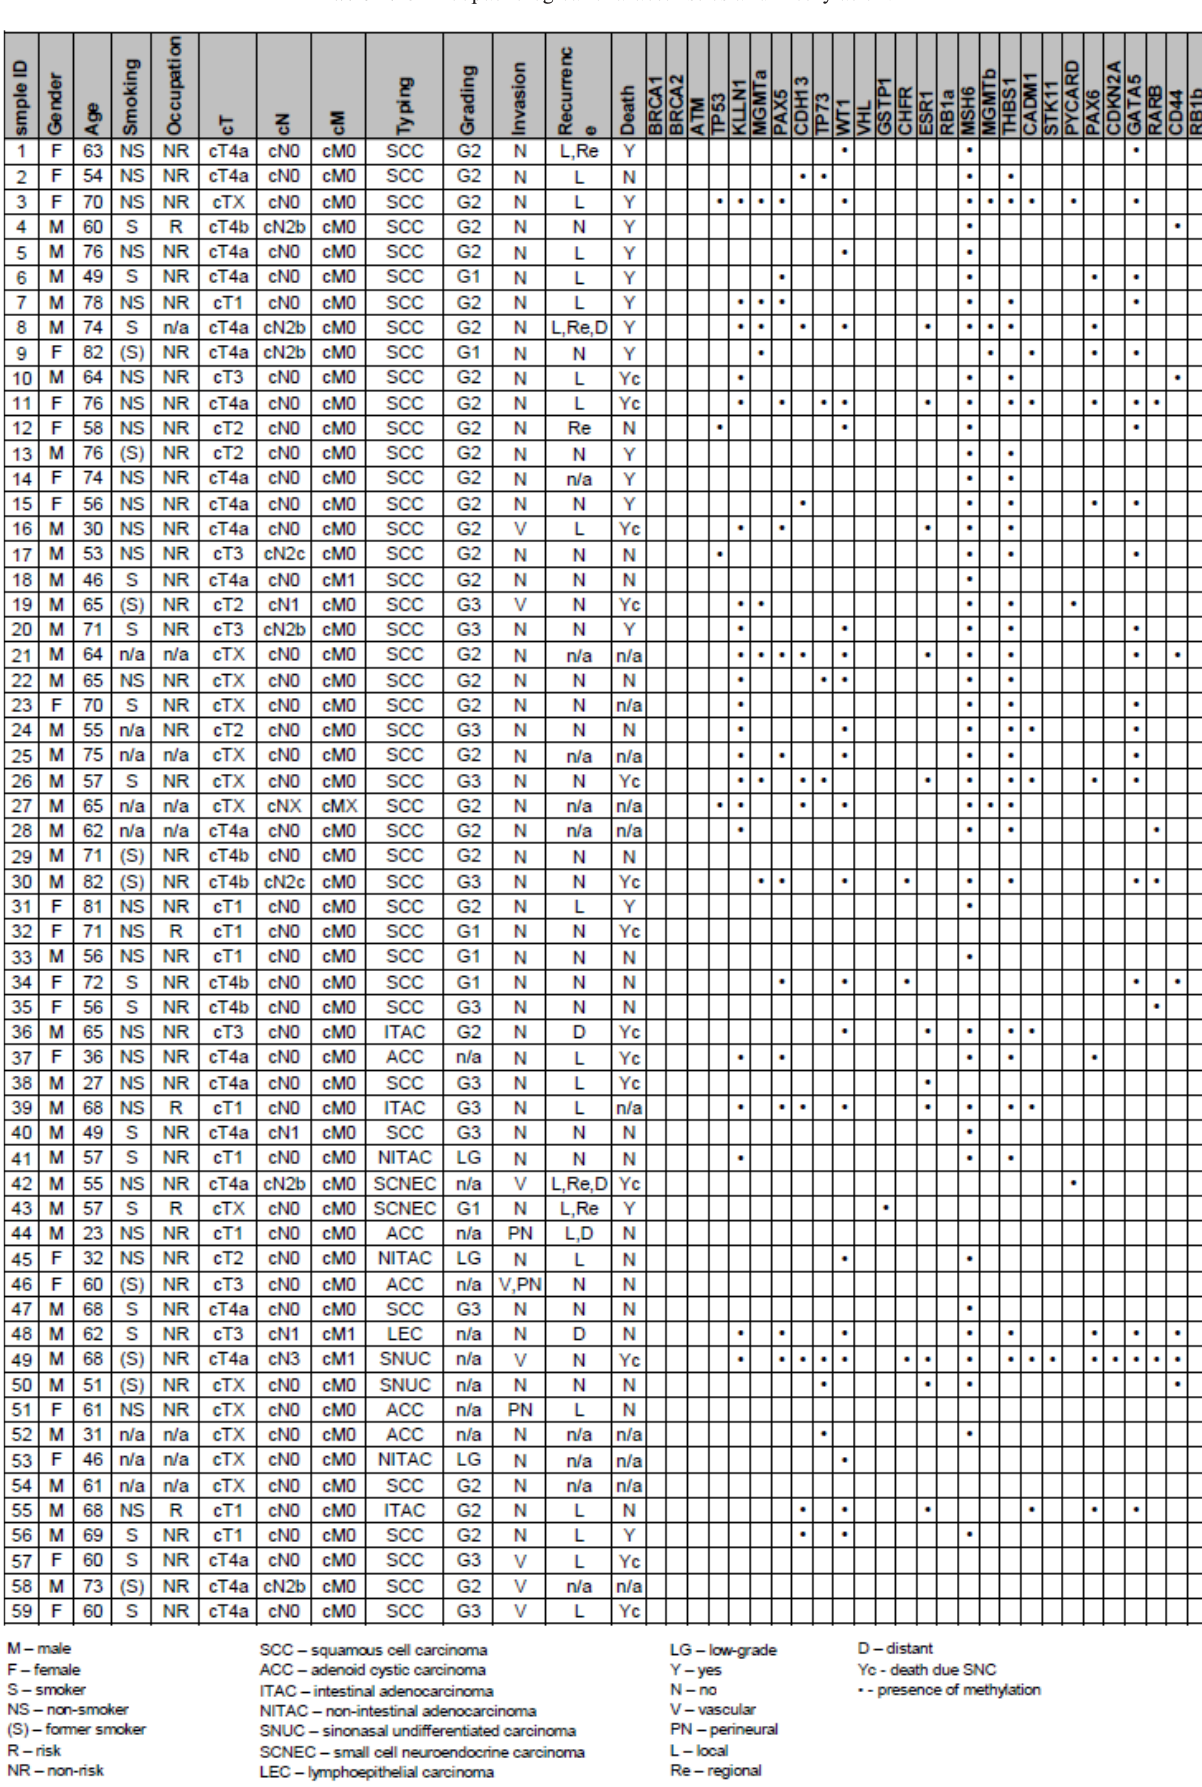
Table 2. Clinicopathological characteristics and